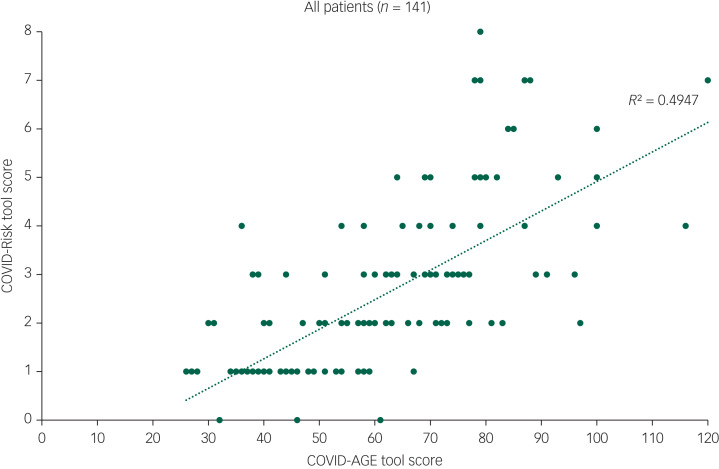
Association between COVID-Risk tool score and COVID-Age tool score: Spearman's r = 0.776, P < 0.001, R2 = 0.4947.